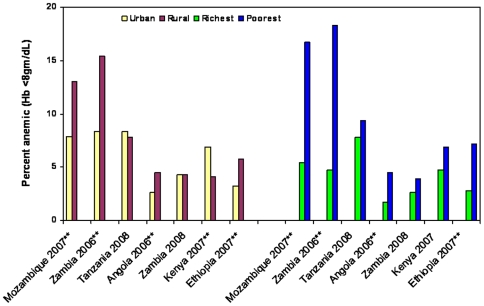
Moderate-to-severe anemia rates in children.Anemia rates (Hb<8gms/dl) in children under-5 years of age by urban or rural setting and by richest or poorest wealth quintile, national Malaria Indicator Surveys in African countries. *While testing was done in the Rwanda DHS, the comparisons were provided in different categories and are not comparable to the other studies. **Statically different with P-value<0.05. For Zambia, substantial increases in malaria intervention coverage occurred between the 2006 and 2008 surveys and likely accounts for the observed reduction in severe anemia, predominantly in rural and poor populations.